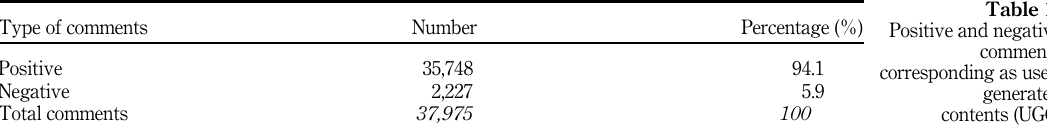
Table 1. Positive and